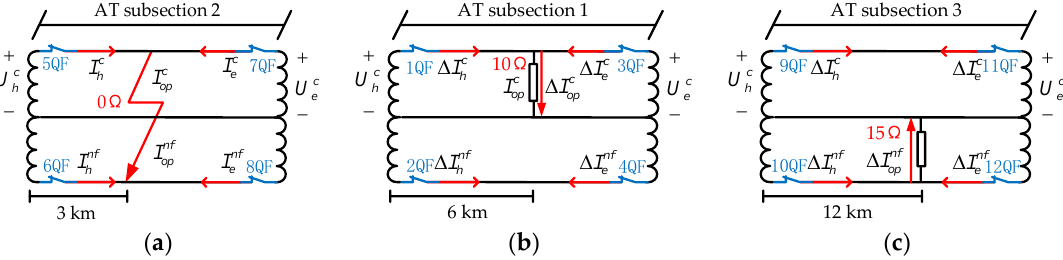
Figure 13. Simplified diagram of information collection and fault locations in the cases of the three typical faults: ( a ) C-NF fault at AT subsection 2 in 3 km with 0 Ω transition resistance; ( b ) C-G fault at AT subsection 1 in 6 km with 10 Ω; ( c ) and NF-G fault at AT subsection 3 in 12 km with 15 Ω.